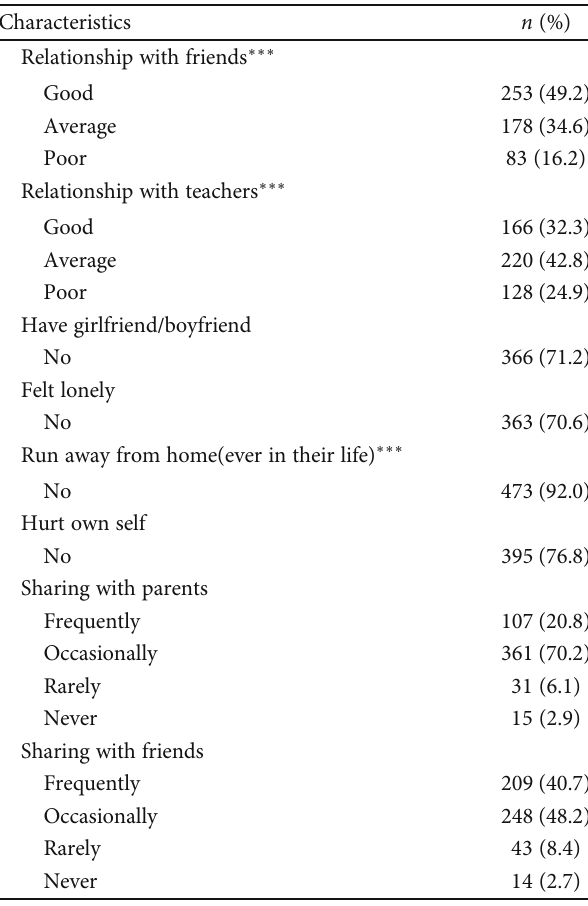
Table 2: Educational, behavioral, and psychological characteristics of the respondents ( n = 514